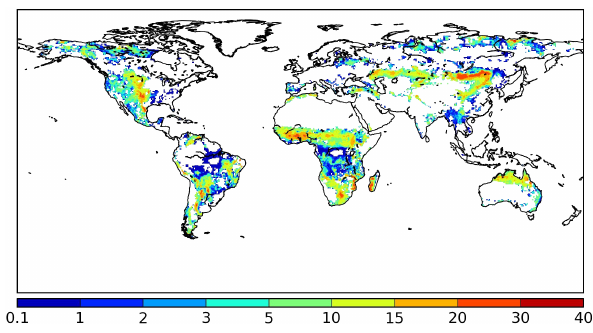
Figure 8. The fire carbon emissions as percentage (%) of net pri- mary production (NPP) for 2003–2012.